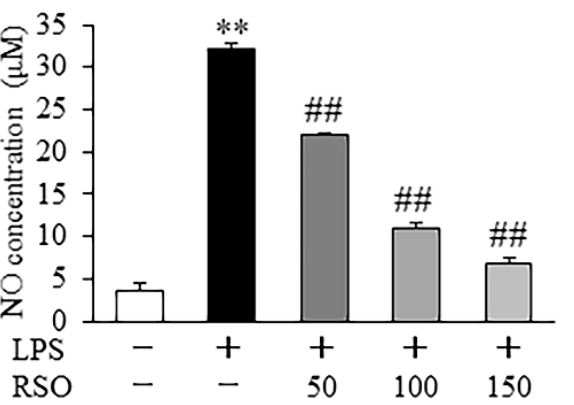
Figure 4. Effect of RSO on NO contents of LPS-induced RAW 264.7 cells. Cells were treated by RSO (0, 50, 100, and 150 μg/mL) and LPS (l μg/mL) for 24 h; then, culture solution was obtained for detection, n = 3. ** p < 0.01 vs control group; ## p < 0.01 vs LPS-induced group.